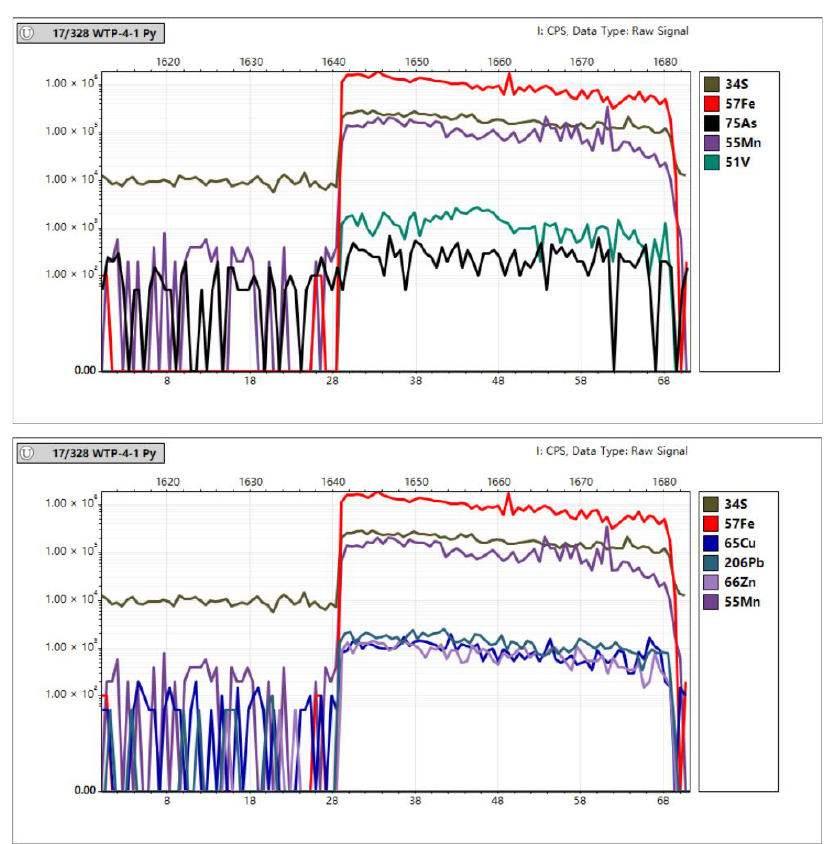
Figure 12. Time-resolved depth profiles of Pb and Mn in Sample QX-1.